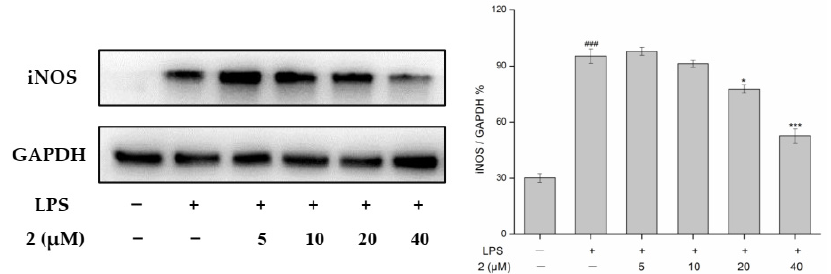
Figure 5. iNOS protein levels of compound 2 with different concentrations (5, 10, 20, 40 µM) were detected by a Western blot assay. (*** p < 0.001, * p < 0.05 compared to the LPS-treated group. ### p < 0.001 compared to the blank group.) .